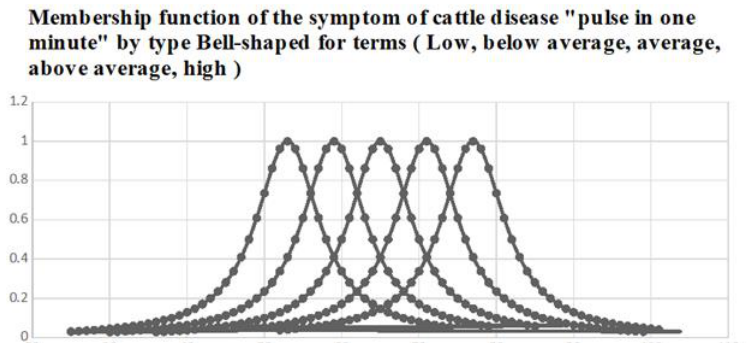
Figure 4. Membership function of output terms before learning .